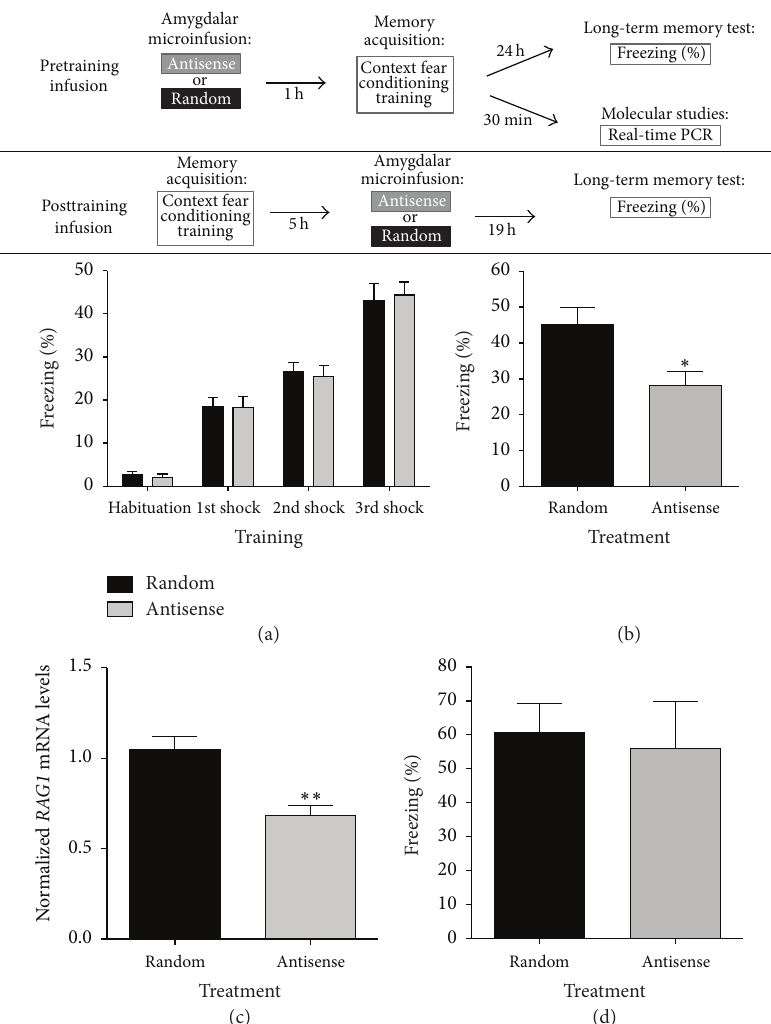
Figure 4: RAG1 antisense amygdalar treatment impaired consolidation of context fear conditioning. Top panel: diagram depicting the experimental design of these experiments for pretraining or posttraining amygdalar antisense or random oligonucleotide microinfusion experiments.Inthepretrainingmicroinfusionexperiments,micereceived RAG1